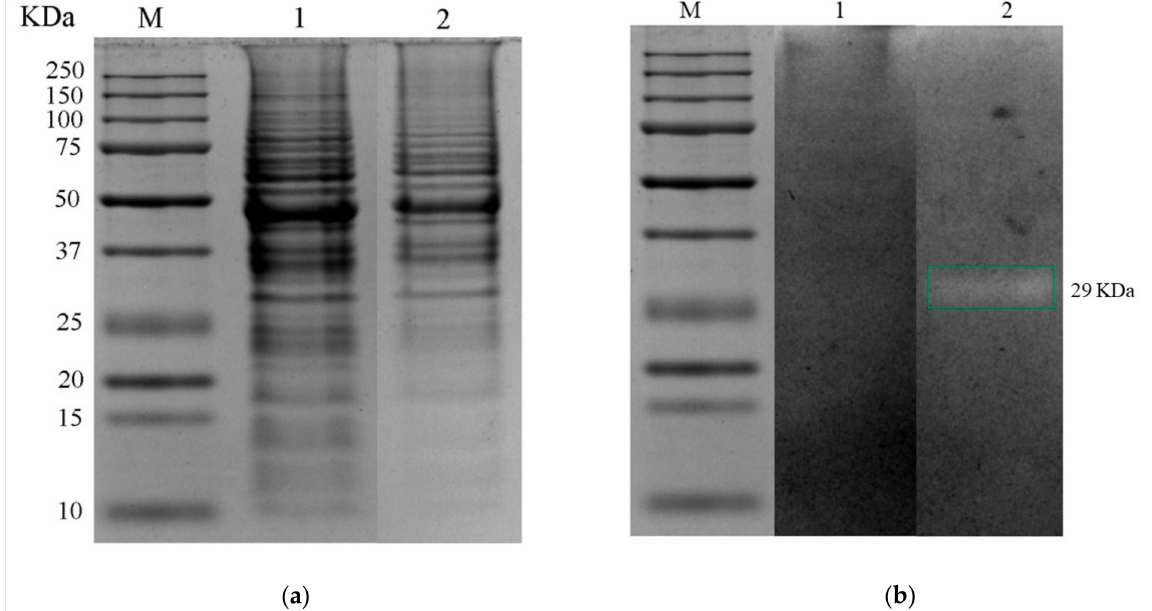
Figure 2. ( a ) SDS–PAGE 12% and ( b ) zymogram of soluble fraction of intracellular proteins obtained with the different treatments. M—molecular-weight marker Bio-Rad Dual Xtra; Lane 1—control treatment; Lane 2—gastrointestinal-conditions